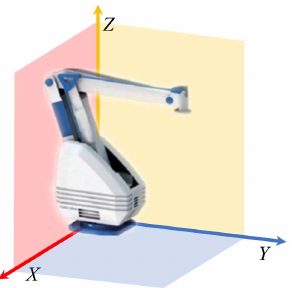
Figure 1. Palletizing robot coordinate